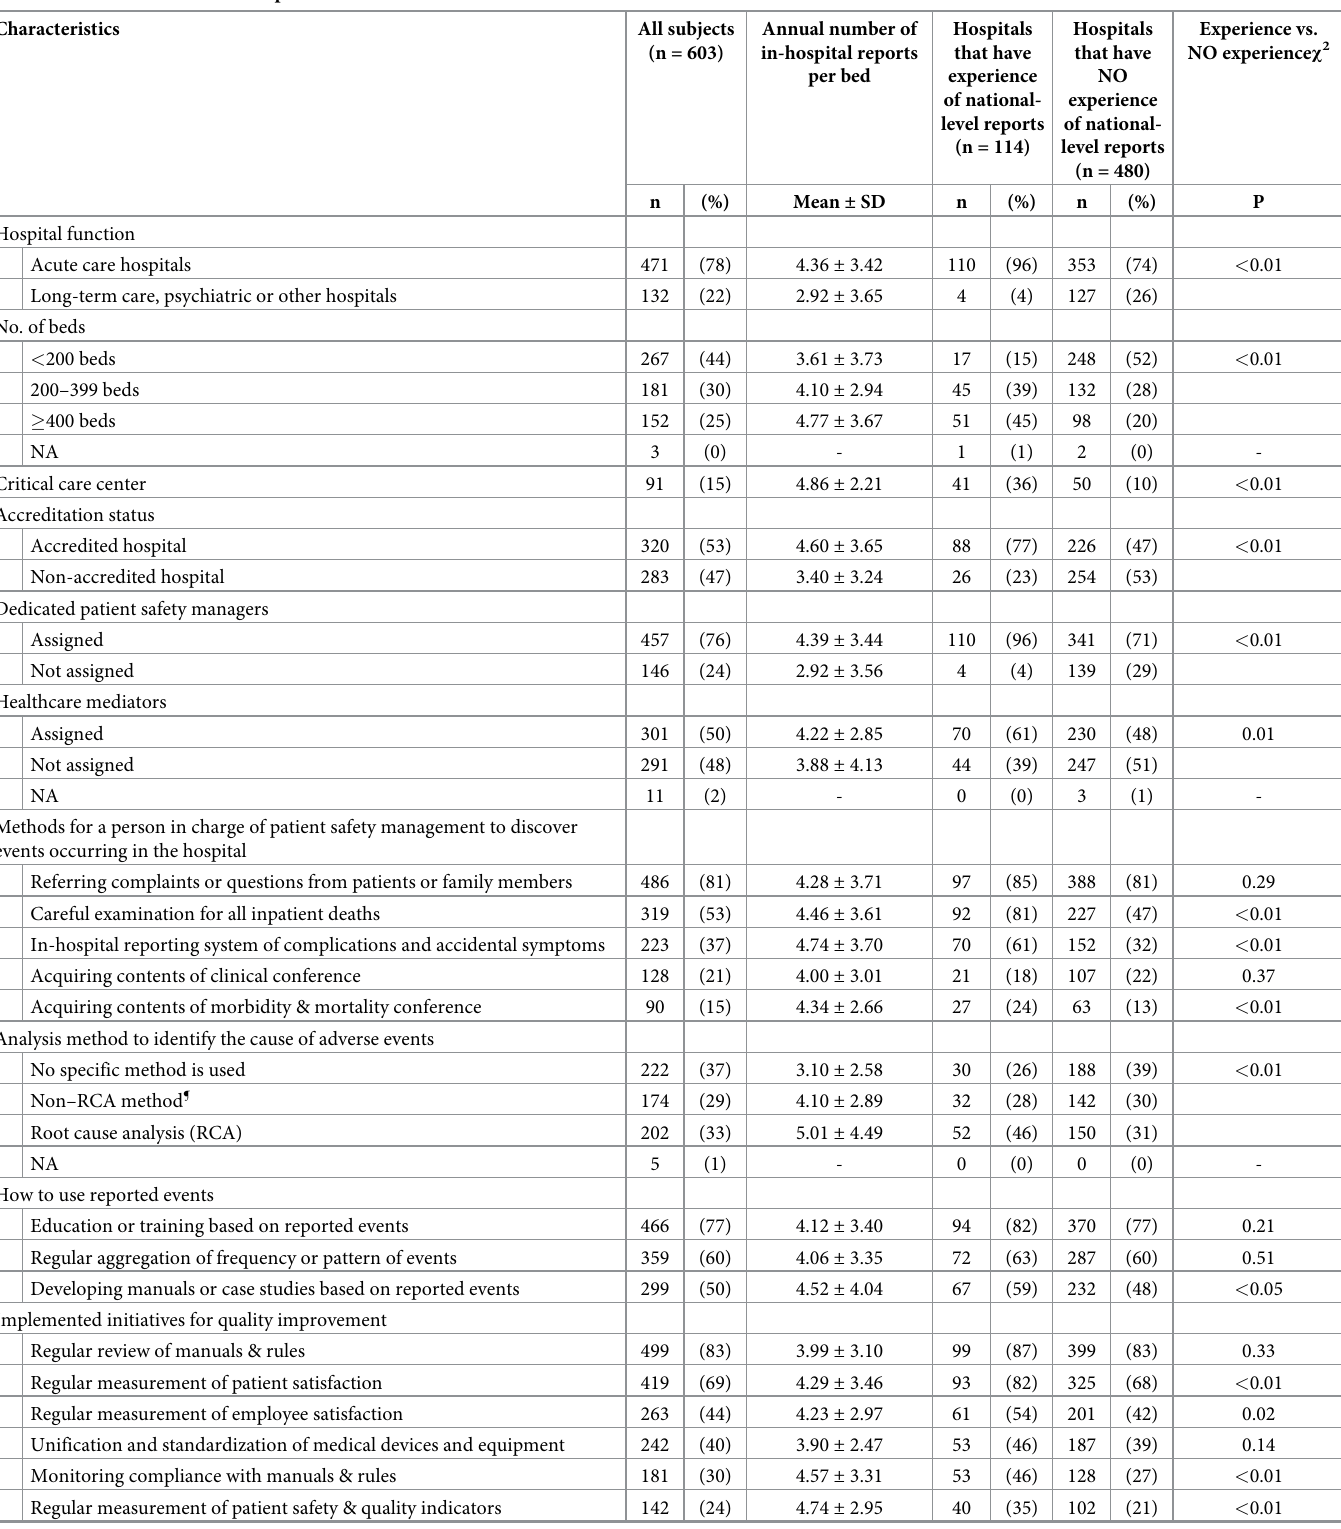
Table 1. The characteristics of respondents.